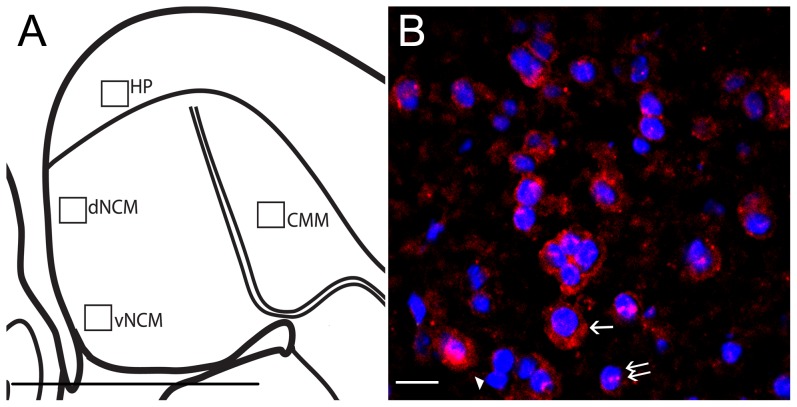
catFISH in auditory forebrain.A) Schematic of auditory forebrain in sagittal plane. Boxes represent brain regions imaged and measured from catFISH-processed brain sections. Anterior is toward the right, dorsal is up. HP  =  hippocampus, CMM  =  caudomedial mesopallium, dNCM  =  dorsal caudomedial nidopallium, vNCM  =  ventral caudomedial nidopallium. B) 60X image of catFISH procedure showing Arc mRNA (red) and DAPI-stained nuclei (blue). Single arrow points to cytoplasmic-only labeled cell, double arrow points to double-localized cell, and arrowhead indicates cell without Arc mRNA staining. Scale bar in A = 1 mm, B = 10 µm.